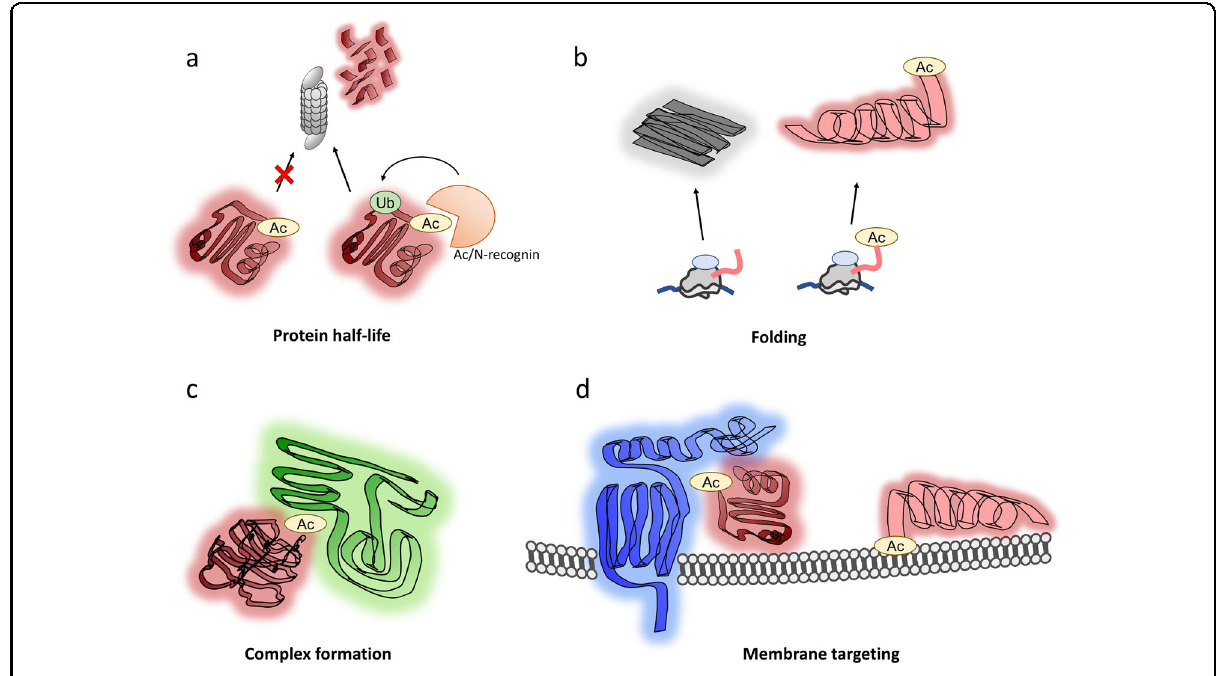
Fig. 3 Functions of N-terminal acetylation. Nt-acetylation has many functions in the cell. a In some cases, Nt-acetylation targets proteins for polyubiquitination and proteasomal degradation, and in other cases, it protects against such degradation. b Nt-acetylation is required for the proper folding of some proteins. c Protein – protein interactions (PPIs) in protein complex formation are in some cases mediated or augmented by Nt- acetylation. d Nt-acetylation serves to target some proteins for membranes, either through PPIs with an integral membrane protein or through direct interactions with membrane lipids. Ac acetyl group, Ub